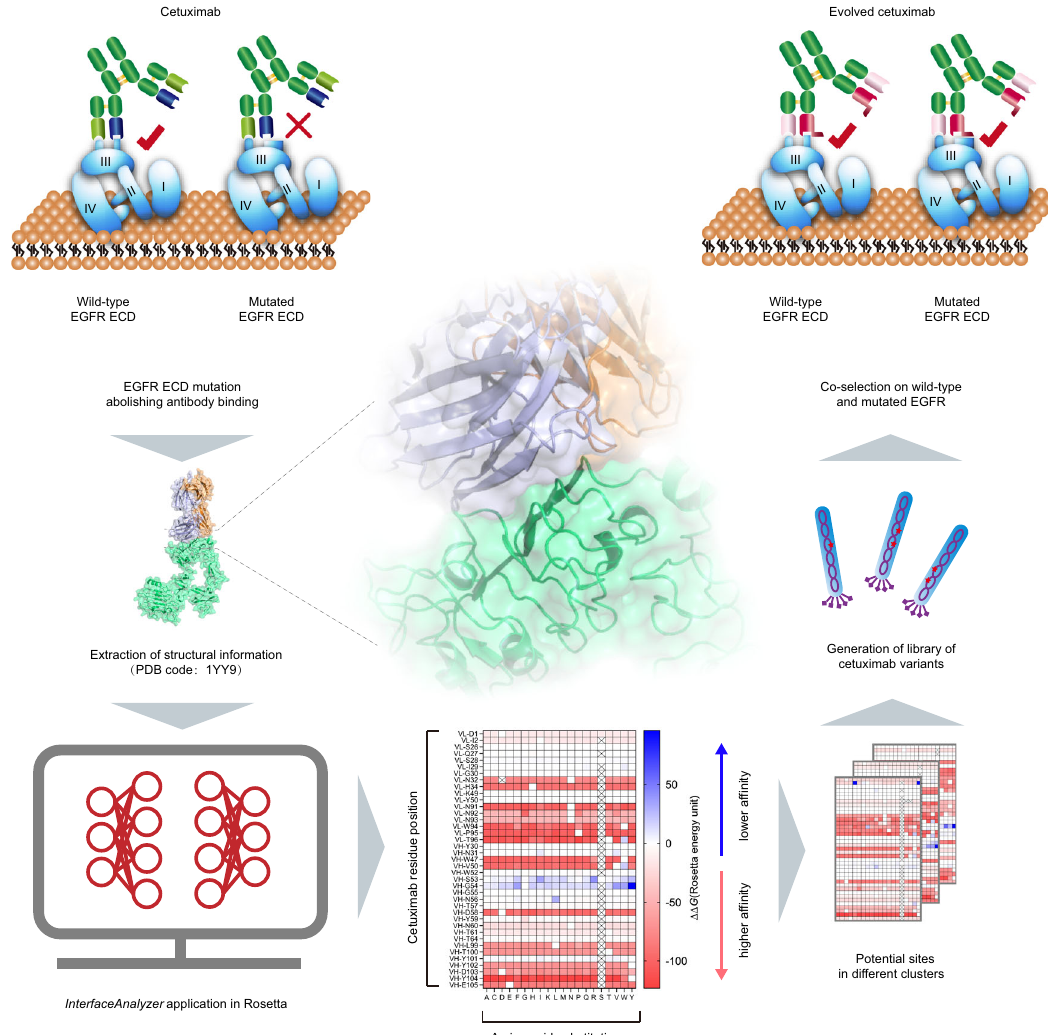
Fig. 2 | Schematic diagram of the SGAPAE approach for directed evolution of cetuximab. The structure-guided and phage-assisted evolution (SGAPAE) approach was applied to develop cetuximab variants for reversing S492R- or G465R-mediated resistance. First, the crystal structure of the wild-type EGFR/cetuximab Fab complex was obtained from the Protein Data Bank (PDB code: 1YY9). Second, the critical residues in the interface were identi fi ed by evaluating the interfacial free energy of